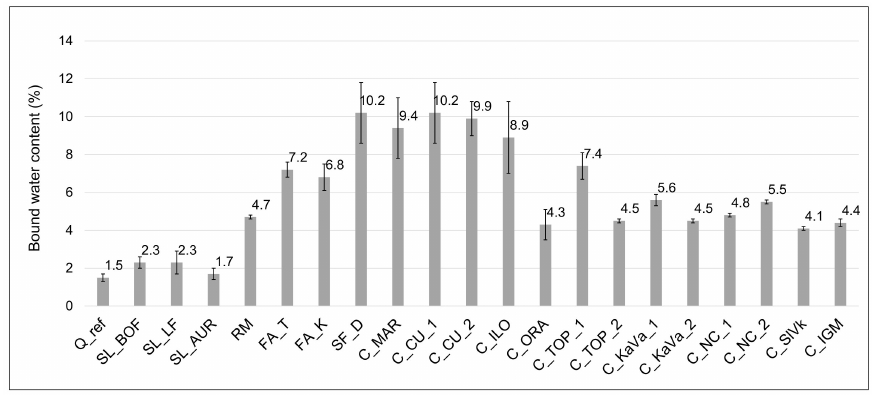
Figure 8. Bound water content for each SCM obtained by the R3 test for